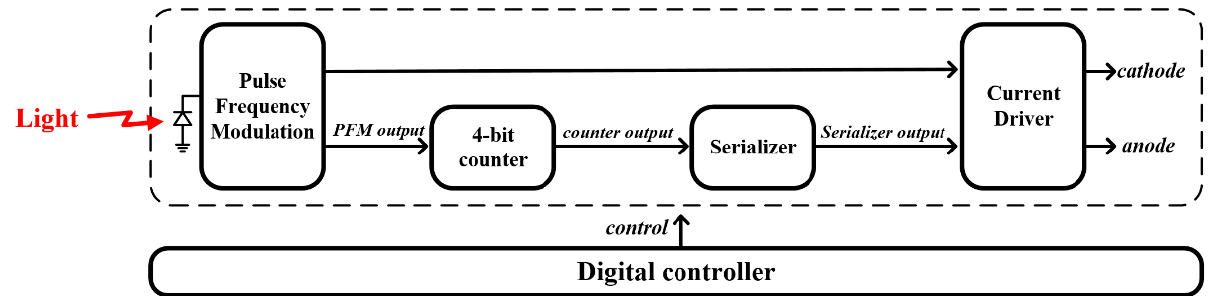
Figure 3. A proposed one-pixel stimulator architecture composed of a pulse-frequency modulation, a 4-bit counter, a serializer, and a current driver. By rejecting a conventional DAC block, we can reduce the proposed system’s active area in this design.